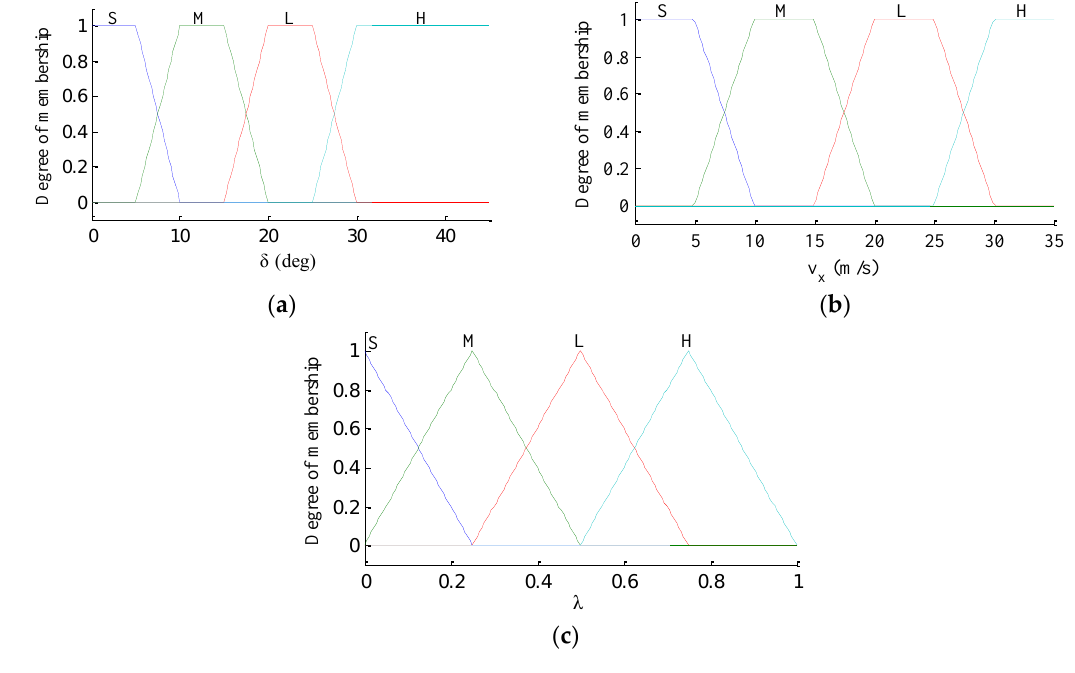
Figure 5. Membership functions of v x , δ and λ . ( a ) v x ; ( b ) δ ; ( c ) λ .